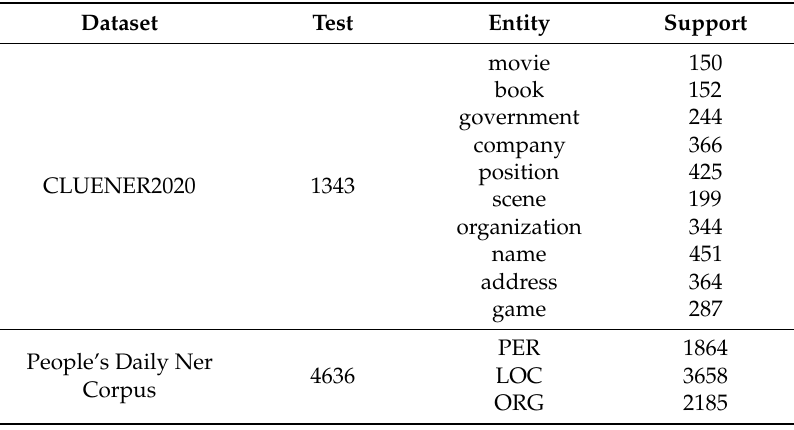
Table 2. Detailed entity distribution in two test